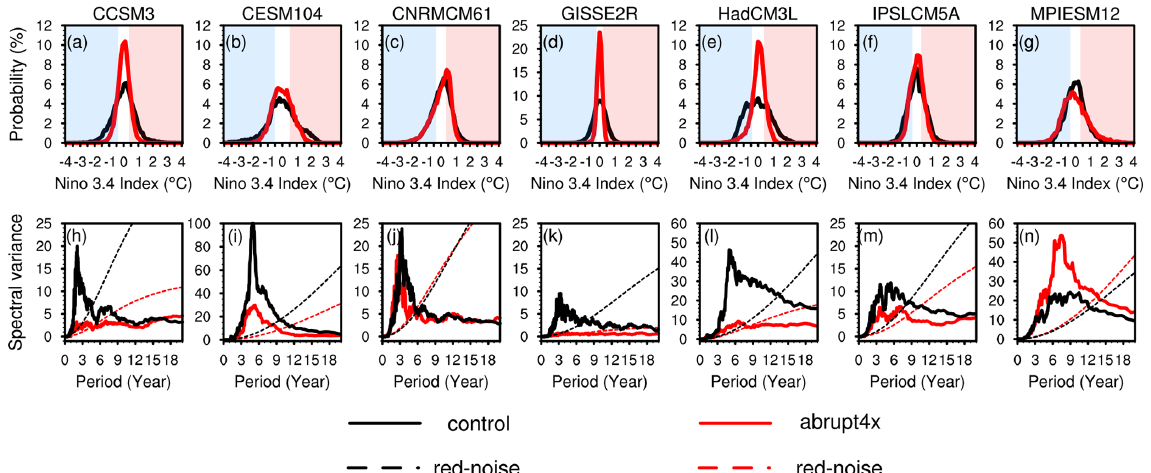
Figure 4. (a–g) Histograms and (h–n) power spectra of the Niño3.4 index in the control and abrupt4xCO 2 . The blue and red shades in the upper panels represent La Niña and El Niño events, respectively. The dashed lines in the bottom panels represent the 0.95 confidence bound of the Markov red noise spectrum in the control and abrupt4xCO 2 .